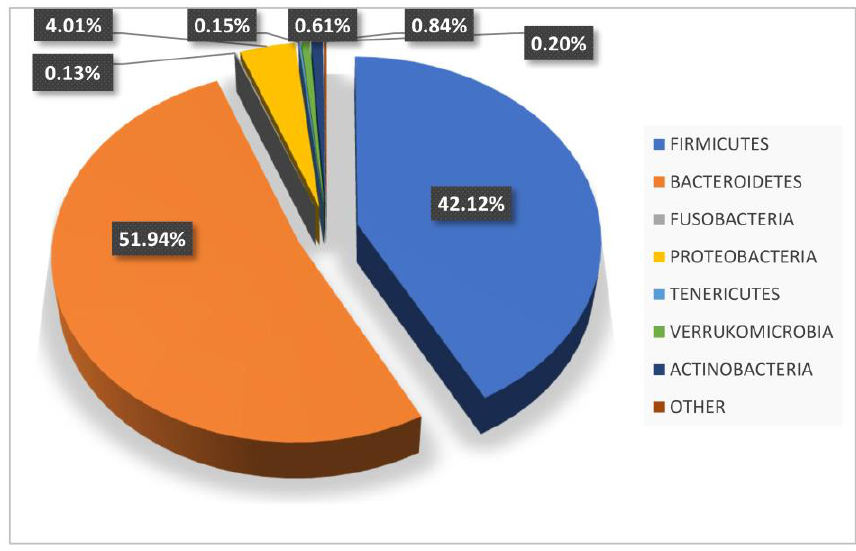
Figure 2. Percentage composition of the microbiota in a eubiotic subject.